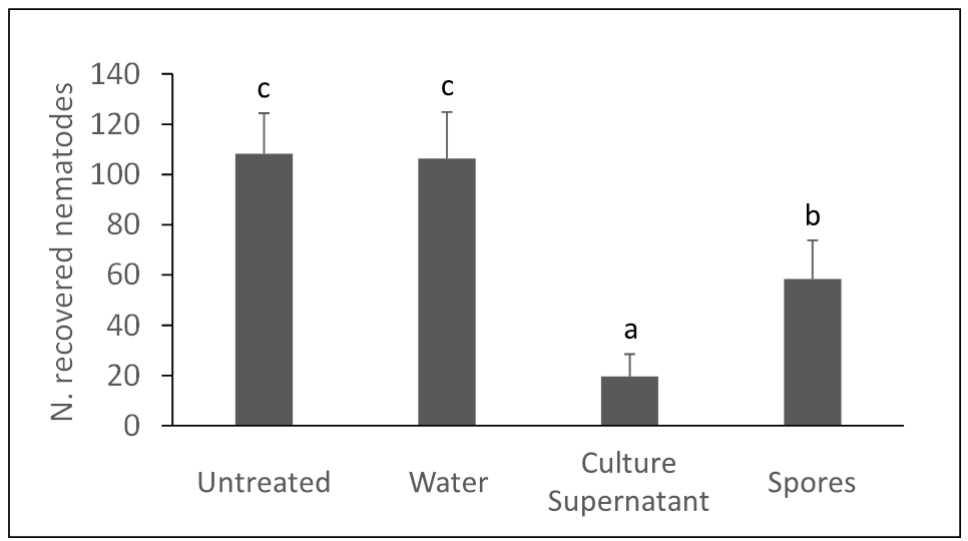
Figure 4. Number (mean ± sd) of Meloidogyne incognita individuals recovered from soil samples treated with different Brevibacillus laterosporus preparations and inoculated with 200 nematode juveniles. Different letters above bars indicate significantly different means (one-way ANOVA, followed by DMRT test, p < 0.001).